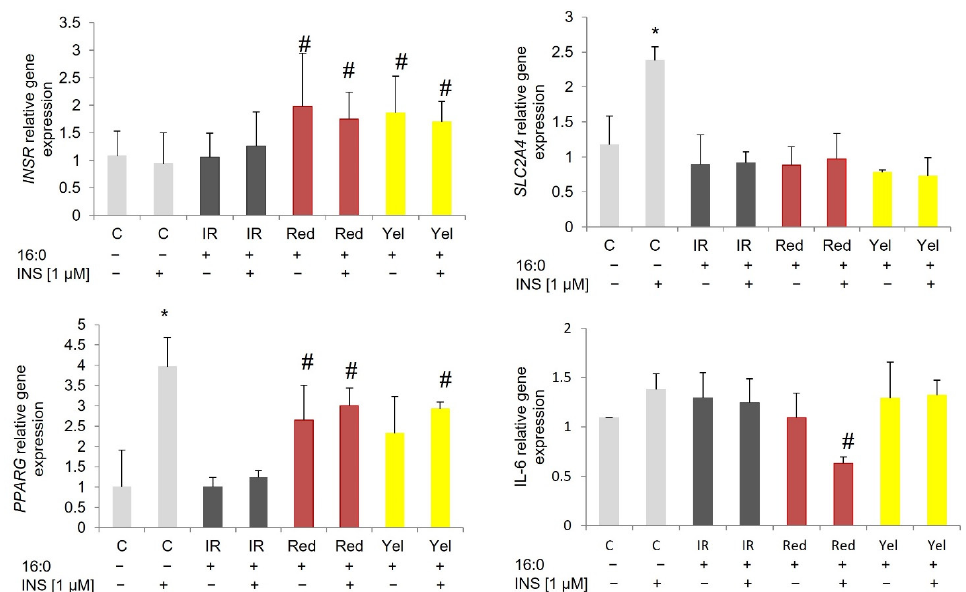
Figure 4. Gene expression in SAT-derived human control adipocytes (C), insulin-resistant adipo- cytes (IR), and IR adipocytes treated with Red and Yellow (Yel) CM fruit extracts the concentration of 0.01 mg/mL. * p < 0.05 compared to the baseline (INS − ) of the appropriate group of cells, # p < 0.05 compared to the corresponding IR adipocytes (baseline INS − and after insulin stimulation INS+). Results have been presented as mean ± SD.